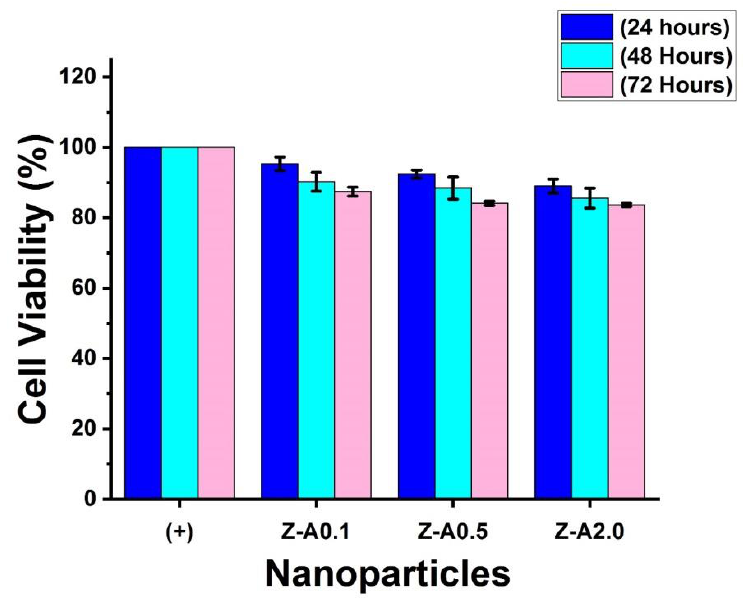
Figure 6. In vitro effect of Z-A 0.1 , Z-A 0.5 , and Z-A 2.0 nanoparticles on human peripheral blood mononuclear cells viability.